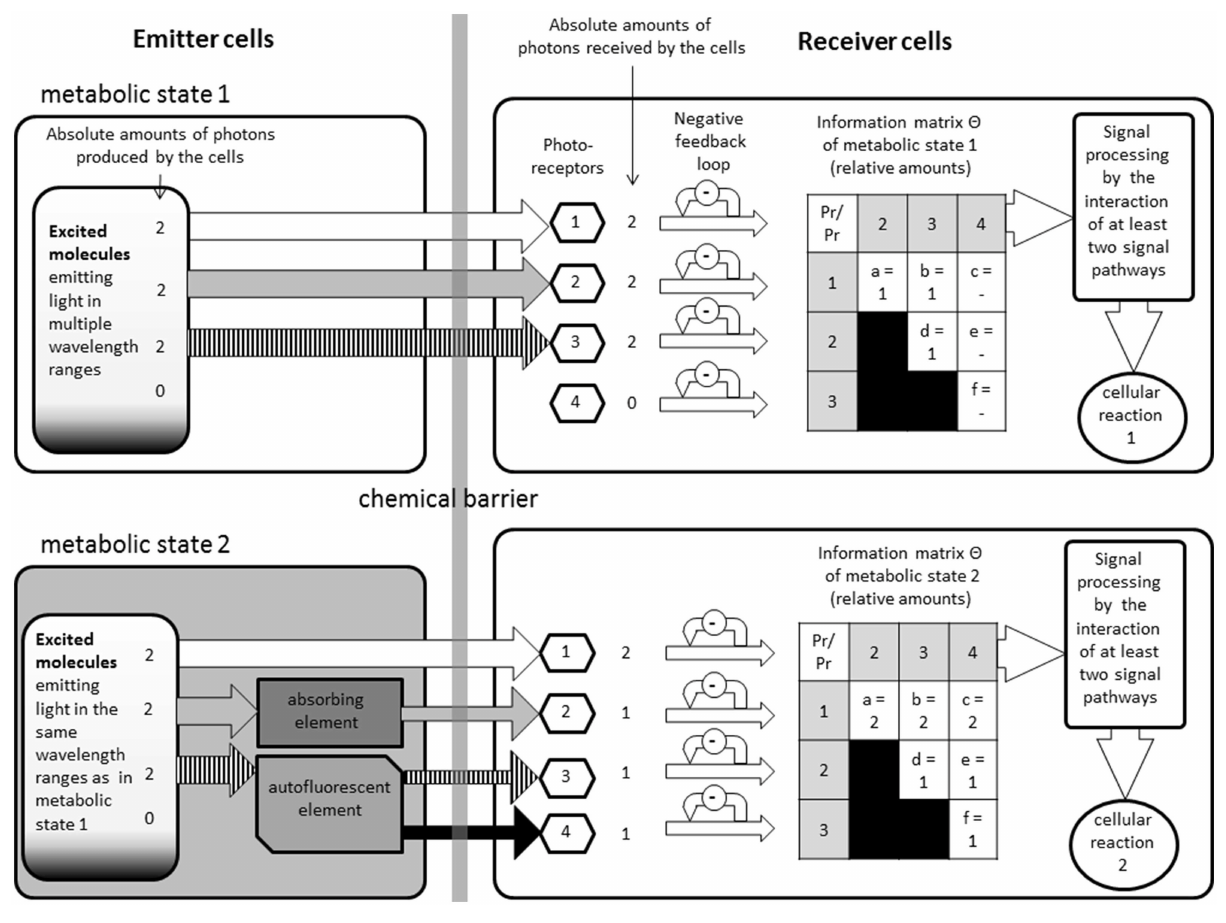
chemical barrier which restrains chemical interactions but makes an optical interaction possible. The information matrixes show the different ratios that could be found if certain wavelengths modulators (autofluorescent or absorbing elements) are present or not, without changing the original emission